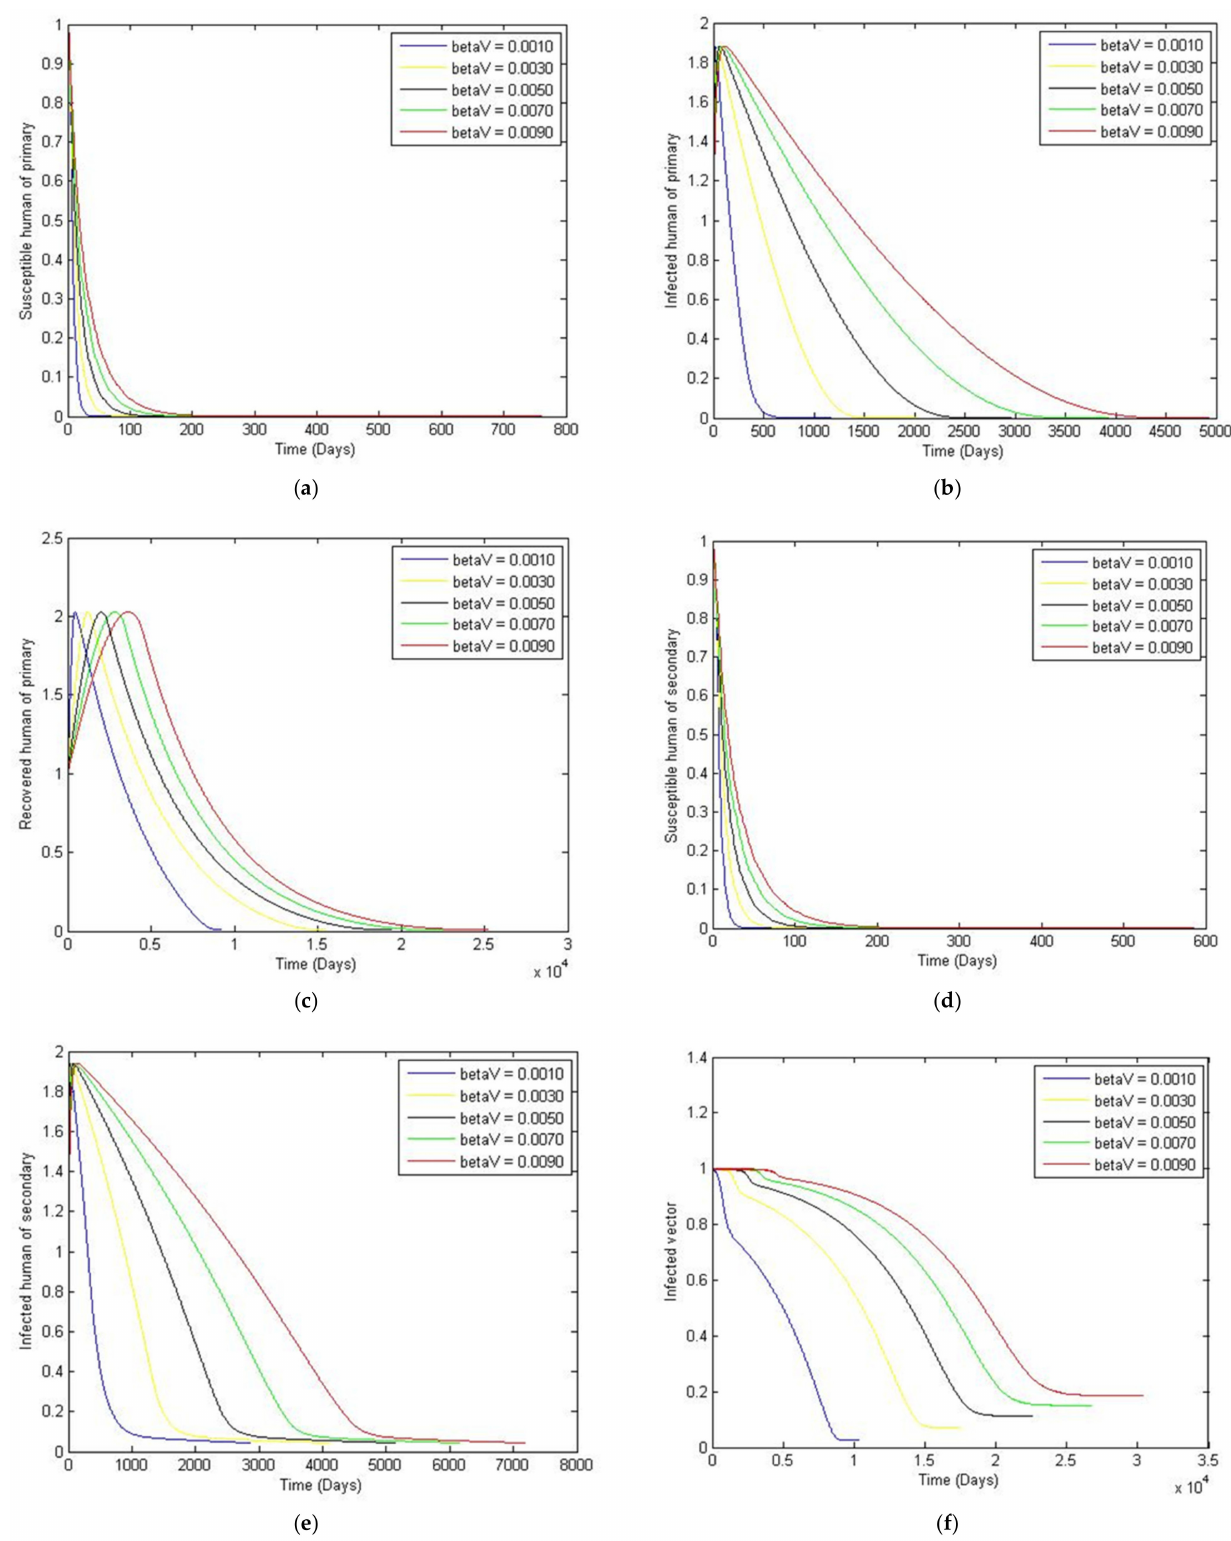
Figure 6. The trajectory of S HP , I HP , R HP , S HS , I HS and I V toward the endemic equilibrium point for R 0 > 1 with a comparison of the transmission rate of the dengue virus from human to vector, β V = 0.0010, 0.0030, 0.0050, 0.0070, 0.0090, and parameter values according to Table 3. ( a ) Susceptibles of primary infection ( b ) Infected population with primary infection ( c ) Recovered human of primary infection ( d ) Susceptibles of secondary infection ( e ) Infected human of secondary infection ( f ) Infected